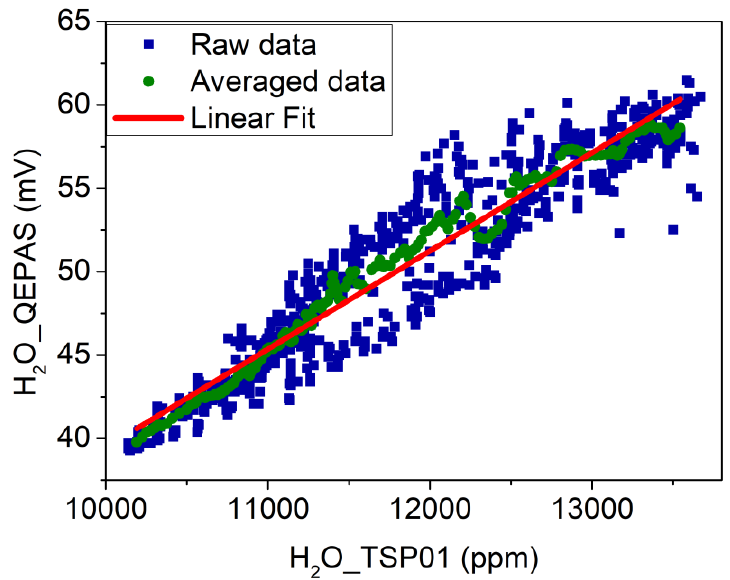
Figure 6. H 2 O QEPAS signal plotted as a function of the absolute humidity (blue squares). Averaged dataset obtained with a moving average on 20 points (green circles); linear fit performed on the averaged dataset (red solid line).